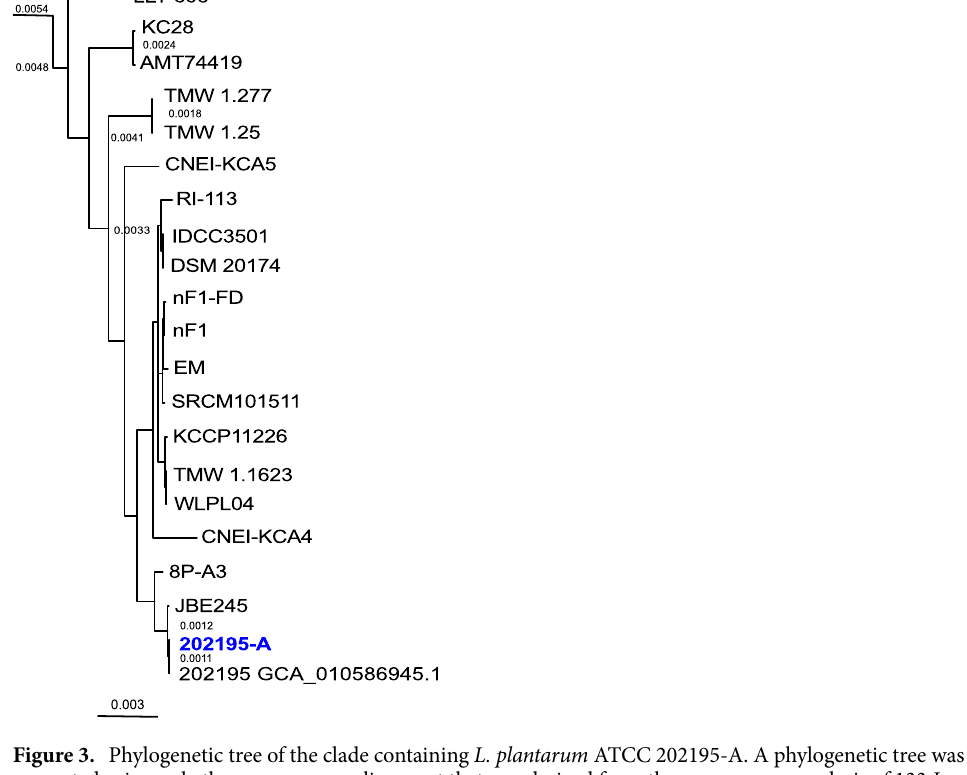
Figure 3. Phylogenetic tree of the clade containing L. plantarum ATCC 202195-A. A phylogenetic tree was generated using only the core genome alignment that was derived from the pan-genome analysis of 133 L. plantarum strains. L. plantarum ATCC 202195 is shown in blue and L. plantarum ATCC 202195 assembly GCA_010586945.1 is labelled as ’202195 GCA_010586945.1’. Branch lengths equal to or greater than 0.0011 are shown. The complete phylogenetic tree of all 133 L. plantarum strains can be found in Supplementary Fig. 1. The phylogenetic tree was generated by Figtree (http:// tree. bio. ed. ac. uk/ stats. html) and edited in Inkscape v1.0.1 (https:// inksc ape. org/ relea se/ inksc ape-1.